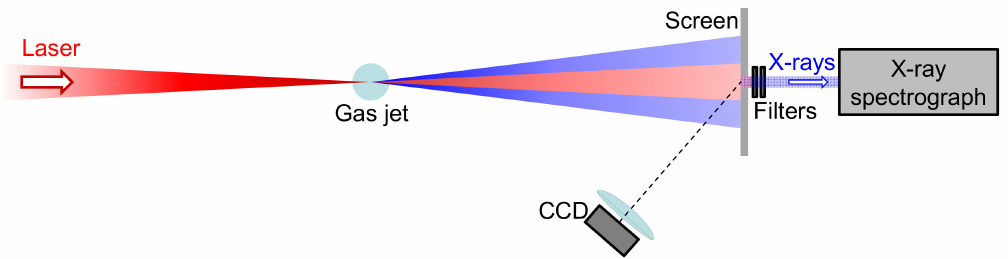
Figure 1. Typical experiment scheme. The laser pulse irradiates the He gas jet target and generates coherent soft X-rays detected with the X-ray spectrograph. In some experimental campaigns, the transmitted laser beam footprint was measured with the Teflon screen and optical charge-coupled device (CCD); the X-rays passed to the spectrograph through the aperture made in the screen.